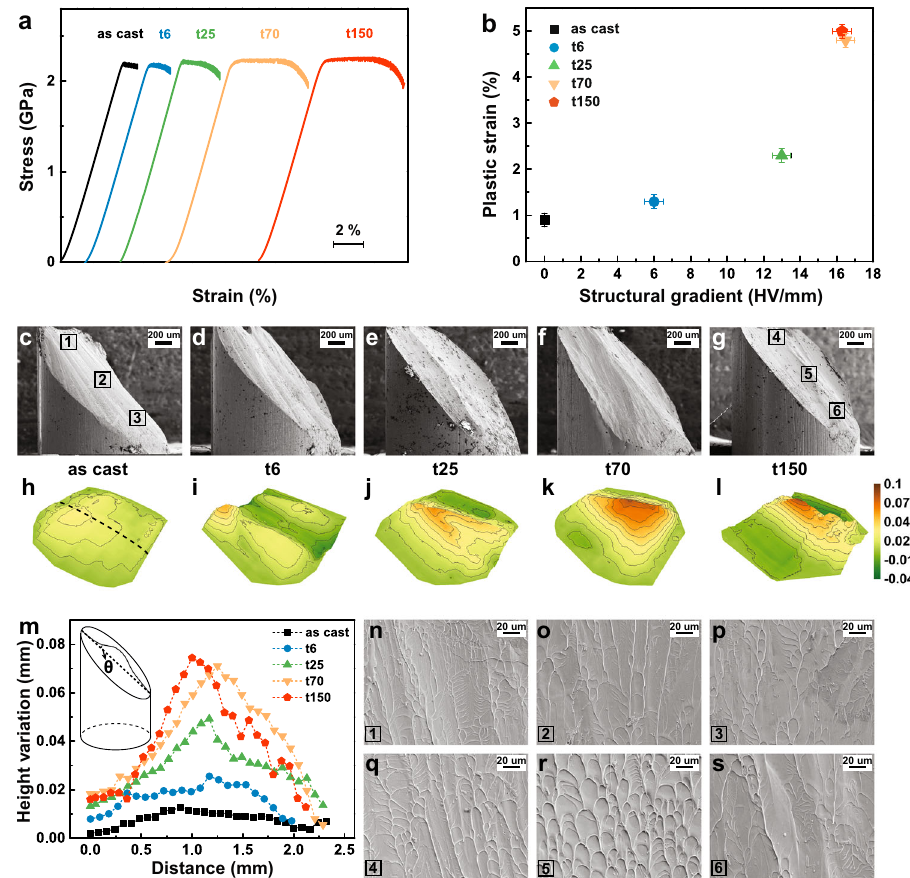
Fig. 3 Mechanical behaviors of the GMG with hard shell and soft core. a Compressive stress-strain curves for the as-cast and treated MGs. b Variation of the plastic strain with the structural gradient. The vertical error bars represent standard deviation from four independent measurements of plastic strain. The horizontal error bars indicate the standard deviation of structural gradient according to the hardness value. c – g Lateral morphologies of the fractured as-cast and GMG samples. h – l The corresponding 3D contours of the fracture surfaces. High and low contours were coloured in brown and green. m Height variation pro fi les of the middle dash line ( h ) along the shear band plane for as-cast and GMG samples. n – s SEM surface morphologies at positions 1 – 3 in the as-cast ( c ) and 4 – 6 in the t150 sample ( g